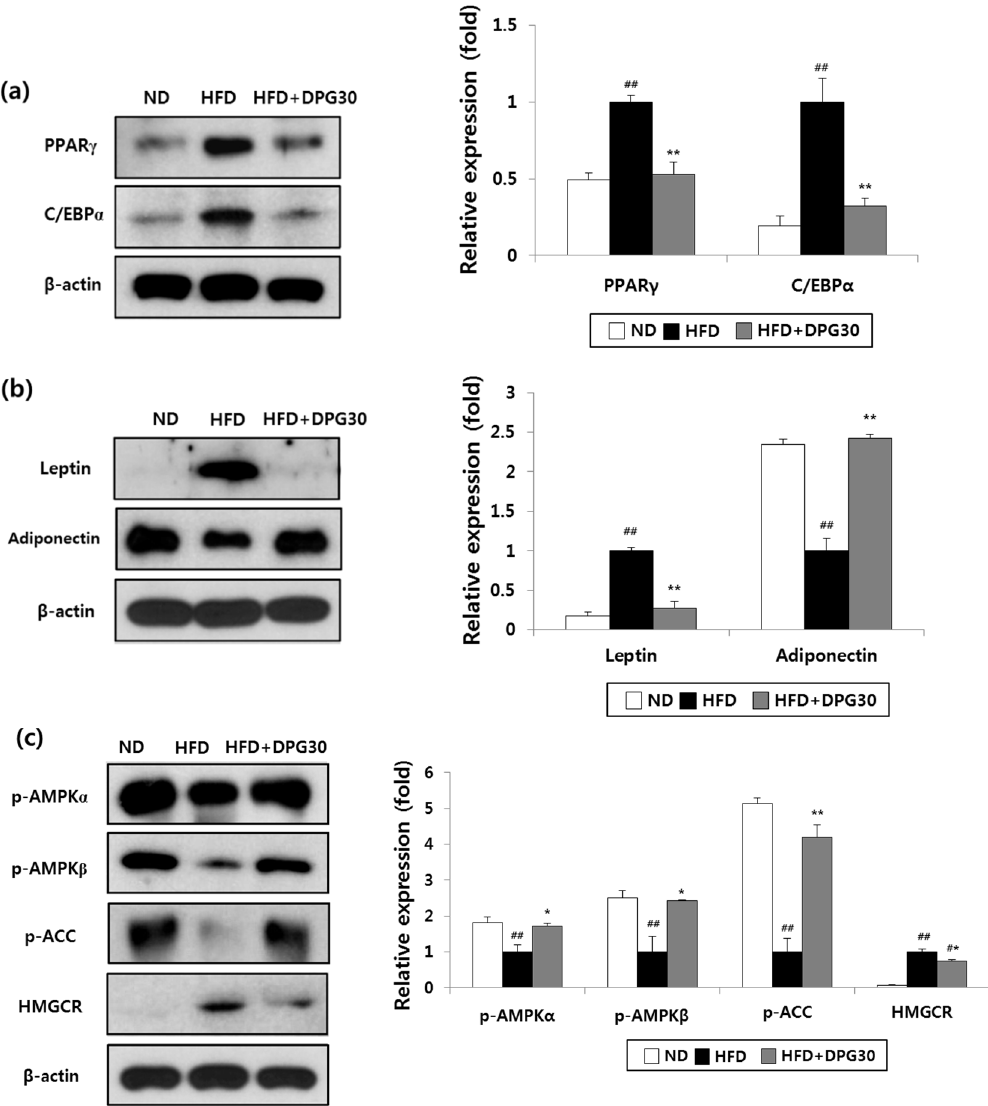
Figure 5. Effect of DPG on the expression of adipogenesis ‐ related proteins in adipose tissue. ( a ) PPAR γ and C/EBP α ; ( b ) leptin and adiponectin; ( c ) p ‐ AMPK α , p ‐ AMPK β , p ‐ ACC, and HMBCR. Values are expressed as mean ± SE. # p < 0.05, ## p < 0.01 compared with ND group, * p < 0.05, ** p < 0.01 compared with HFD group.